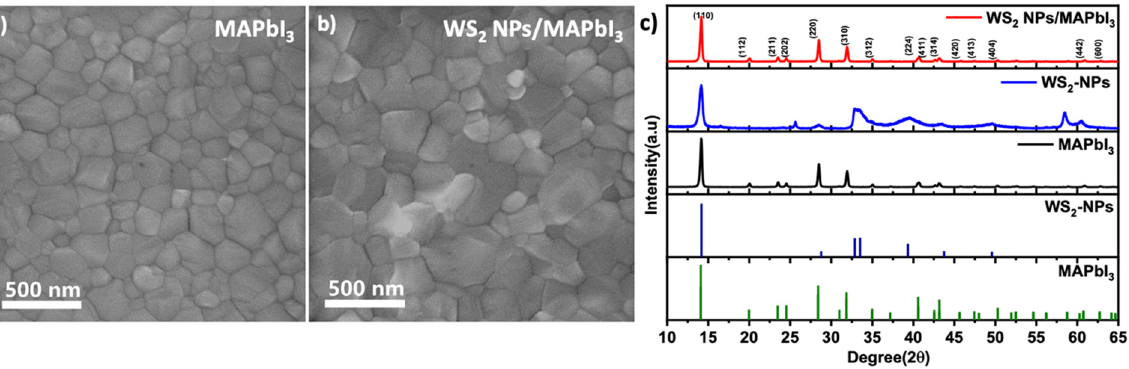
Figure 2. ( a ) SEM image of MAPbI 3 , ( b ) SEM image of WS 2 NPs/MAPbI 3 , and ( c ) XRD patters of the MAPbI 3 , WS 2 NPs, and WS 2 NPs/MAPbI 3 . MAPbI 3 , WS 2 NPs, and WS 2 NPs/MAPbI 3